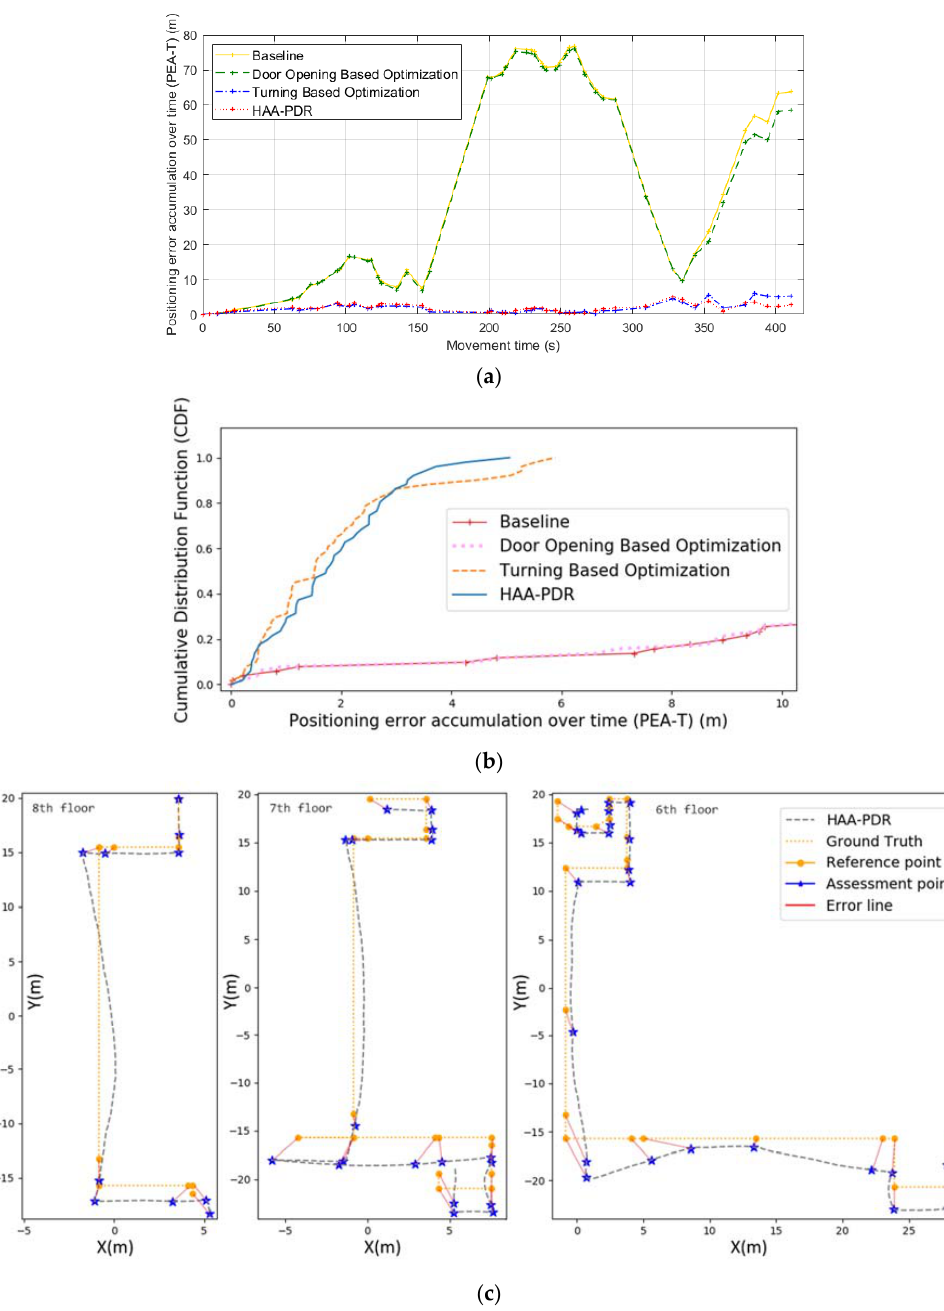
Figure 18. ( a ) The positioning error accumulation over time (PEA-T) at each reference point for Figure 18. ( b ) The baseline and door-opening-based optimization have very high accumulated error, PEA-T, so we show only the CDF error up to an error of 10 m. Obviously, the CDF error of the baseline and door-opening-based optimization is also very high (both can be seen in the values of 85% and 95% CDF error listed in Table 9). As for the CDF error of turning-based optimization and HAA-PDR, we can see that these two methods’ CDF is very close at first. After the CDF reaches about 80%, HAA-PDR gradually outperforms the turning-based optimization. Finally, our HAA-PDR achieves an accuracy of 2.98 m in 85% CDF error and 3.72 m in 95% CDF error, which both surpass all other methods. To better visualize the positioning error of our HAA-PDR system, we display the PEA-T details of assessment points in ( c ). The so-called assessment points are defined as the estimation of reference points by our HAA-PDR system. The gray dashed line and the yellow dotted line represent the HAA-PDR and ground truth, respectively. The yellow points in the line of ground truth are reference points. The blue stars in the line of HAA-PDR are the assessment points. The red short connection lines between each pair of reference and assessment points represent the